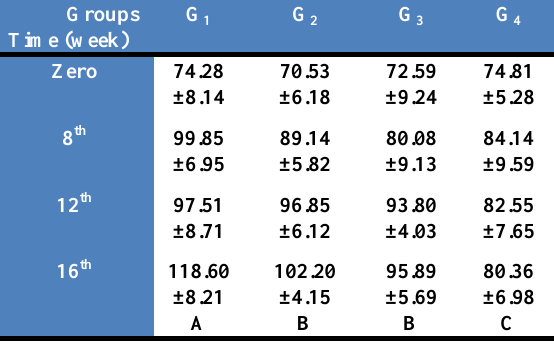
Table, 3: The effect of potassium nitrate and vitamin C as feed additive to the feed of rabbits on the serum triglyceride (mg/dl).